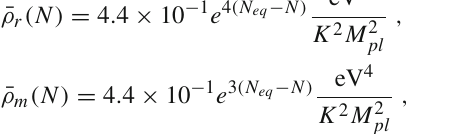
Fig. 2 Numerical integration of the dynamical system (36) from the beginning of radiation to the matter-radiation equality, with initial con- dition at the beginning of reheating x rh = 23 . 6 and y rh = 8 . 4 × 10 35